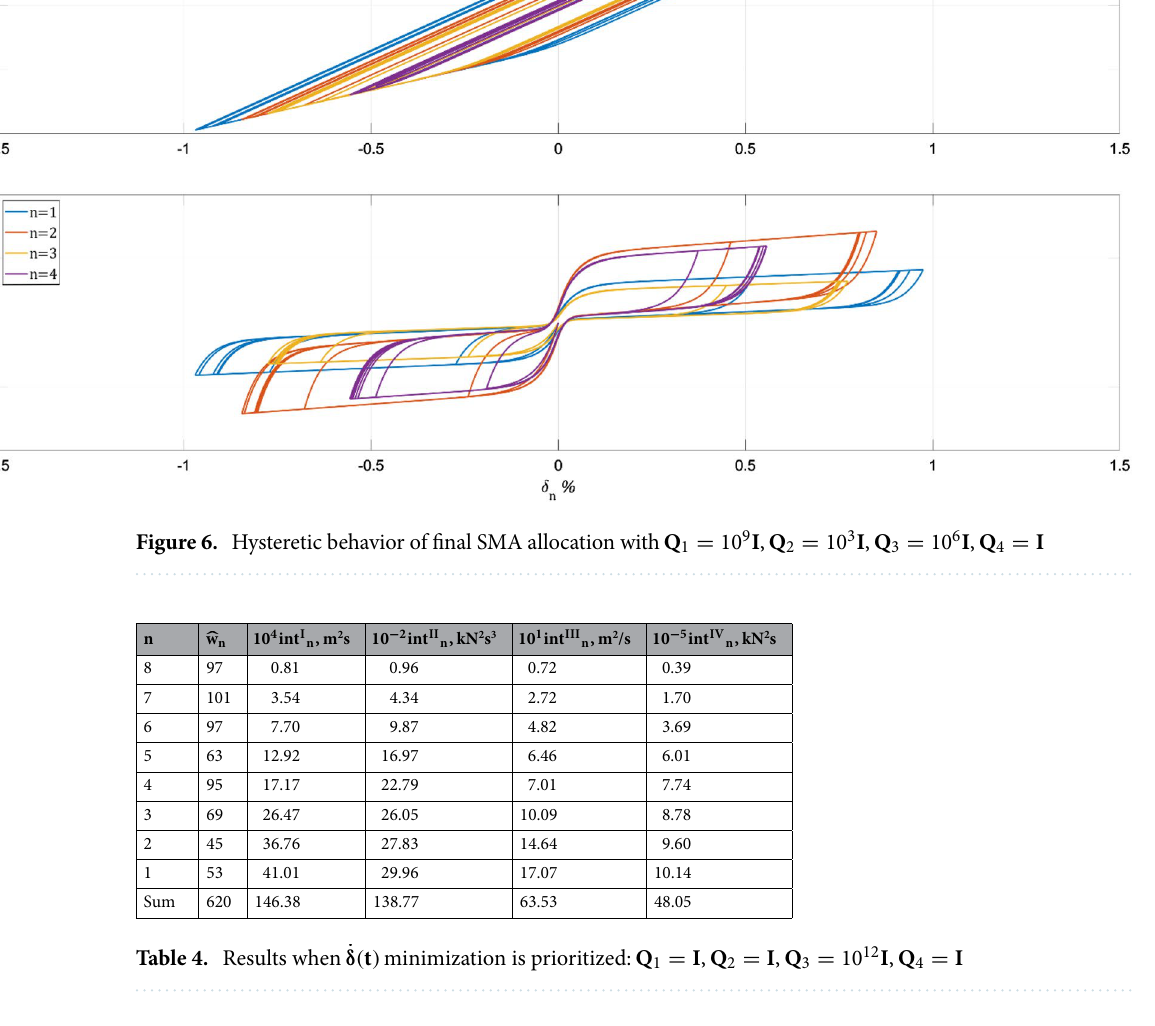
Table 4. Results when